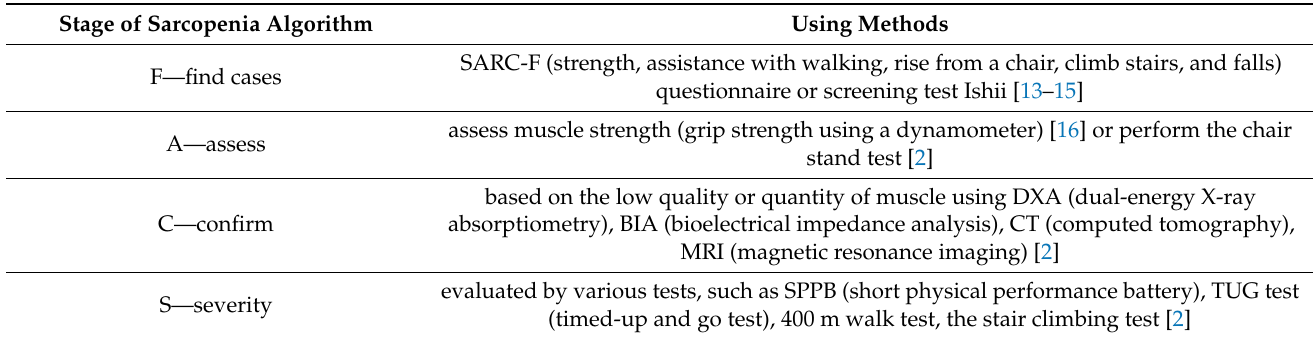
Table 1. Algorithm of the sarcopenia